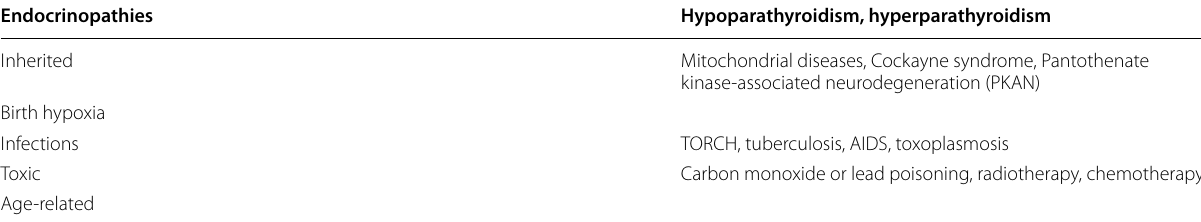
Table 1 Secondary basal ganglia calcifications. Adapted from Tai and Batla